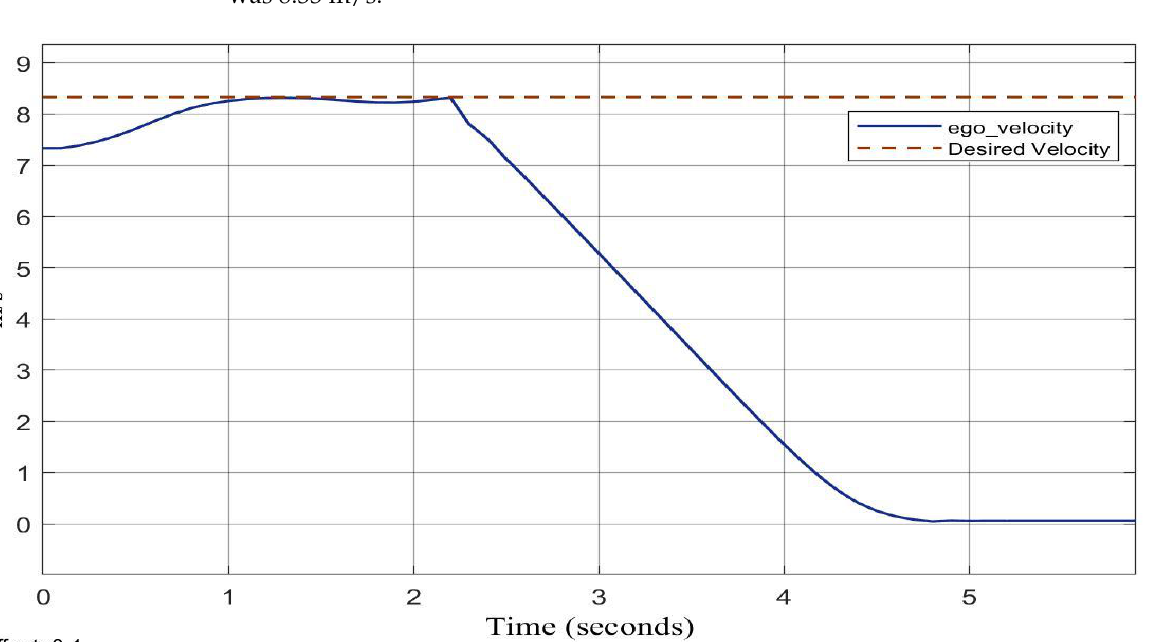
Figure 18. Status of AEBS, FCW, ego car stop, and collision at high speed.